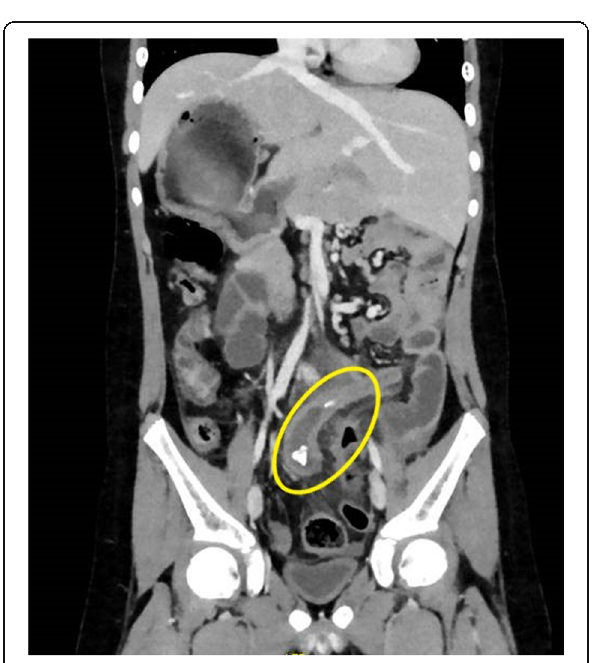
Fig. 2 CT cut showing an obstructing appendicolith in the base of the perforated appendix. (Yellow